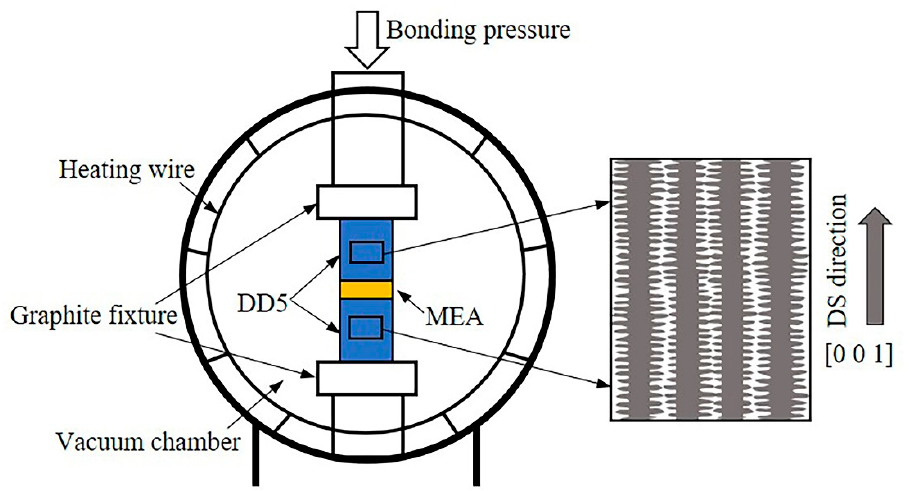
Figure 2. Sketch of the diffusion bonding assembly for (CoCrNi) 94 Al 3 Ti 3 MEA and DD5 single-crys- tal superalloy.